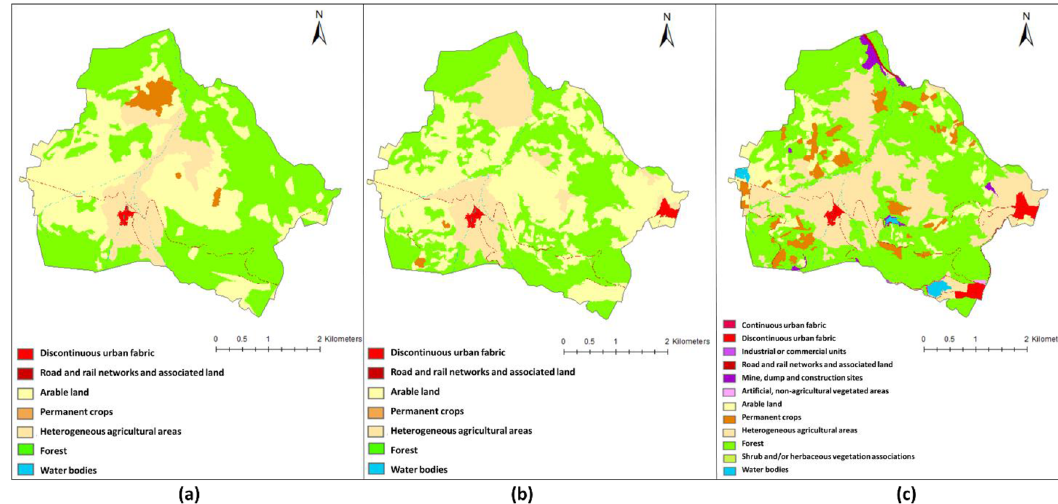
Figure 7. LULC maps of the Aksu region in: ( a ) 1858 ( b ) 1955 ( c ) 2020. LULC